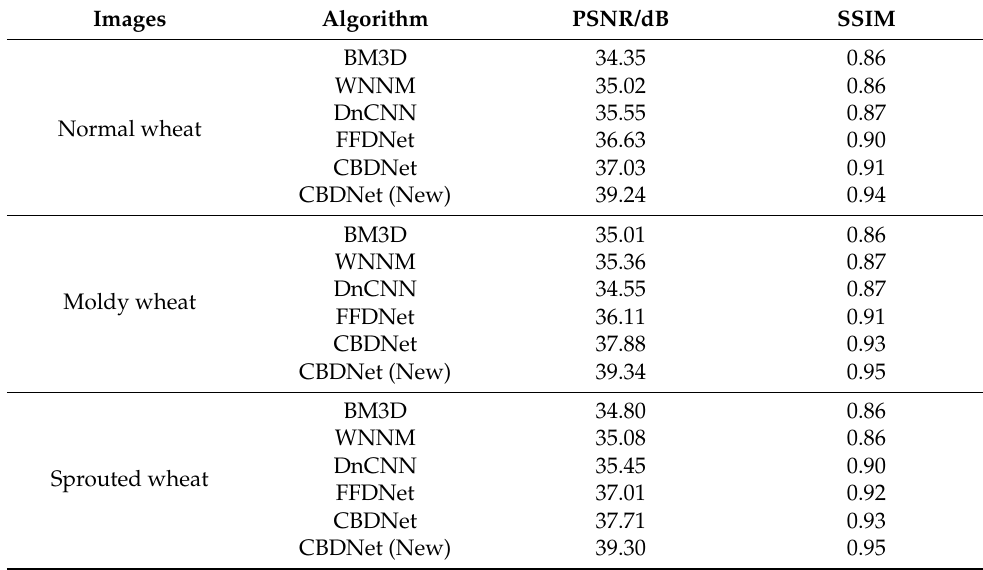
Table 1. A comparison of PSNR/SSIM results based on denoising networks.